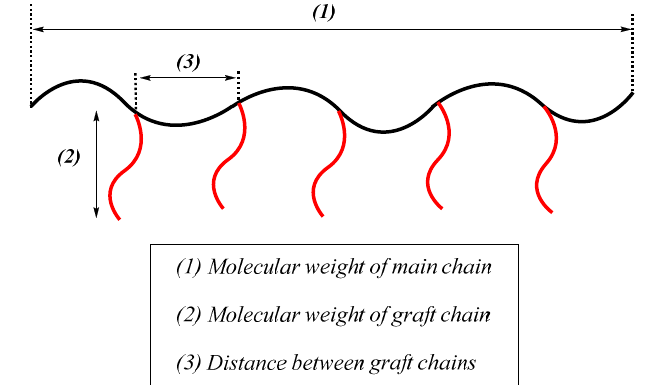
Figure 3. Three structural parameters to define graft polymer. Reproduced with permission from